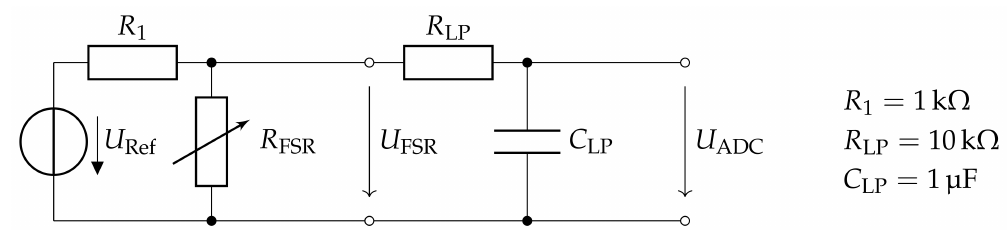
Figure 5. Hardware design of the FSR measurement circuit. Each FSR sensor is low-pass filtered to eliminate measurement noise and adapt to the gait dynamics.